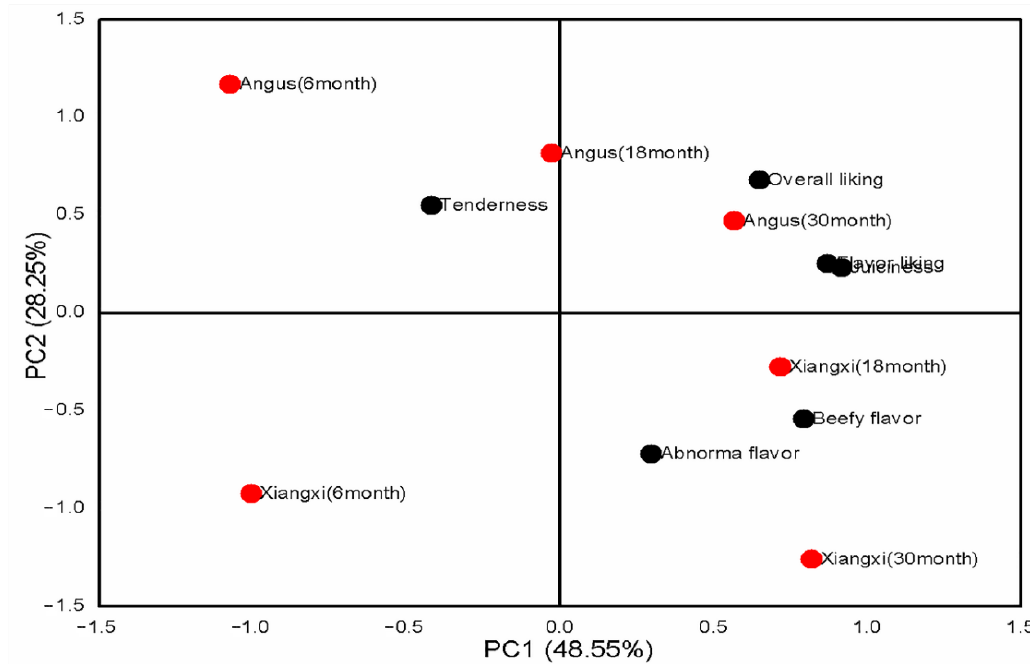
Figure 2. Principle component analysis (PCA) for sensory attributes of LT muscle from Angus and Xiangxi yellow cattle.